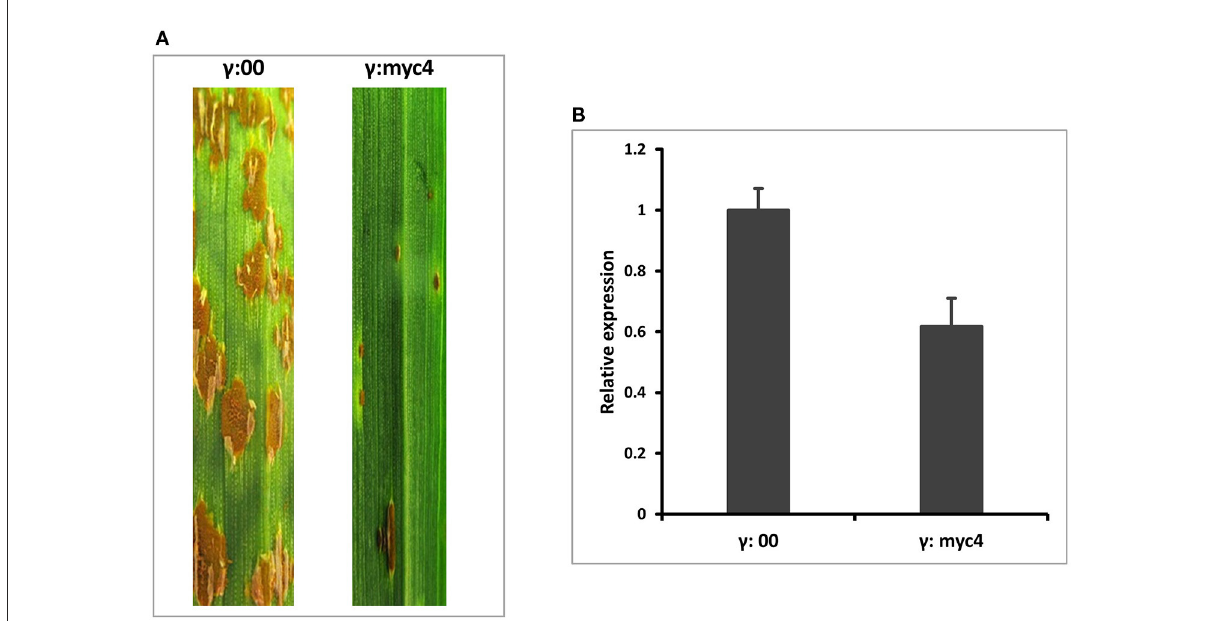
FIGURE2 BSMV-VIGS of TaMYC4 in wheat cultivar Chinese Spring (CS). The first leaf of each plant was rub inoculated with the indicated BSMV constructs at the two-leaf stage and then spray inoculated with Pgt race QFCSC at 10 days after BSMV inoculation. The disease was assessed and photographed at 14 dpi. CS without any viral inoculation, used as a rust inoculation control; γ :00, CS inoculated with BSMV: MYC4 ; γ : myc4 . RNA was extracted from viral-free leaf samples taken from γ :00 and γ : myc4 plants prior to pathogen inoculation. Transcript abundance was quantified via RT-qPCR. Error bars represent standard deviation among three biological reps. (A) Infection types of MYC4 -silenced plants (B) Relative expression of TaMYC4 in γ :00 and γ : myc4 silenced